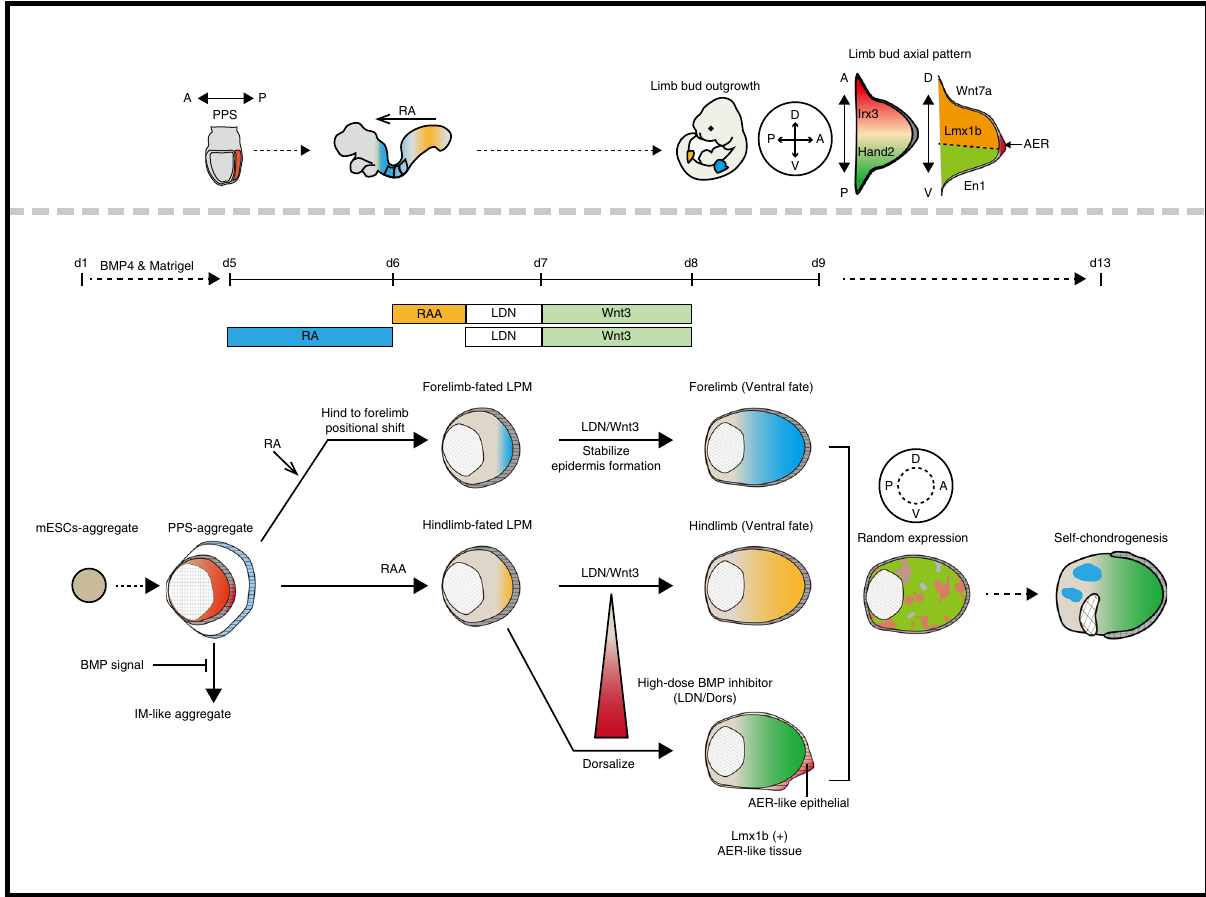
Fig. 6 Schematic model of the differentiation of ES – LB. The developmental process of mouse embryo from E7.5 to 10.5 (above gray dotted line), which correlated with each time-course of the ES – LB differentiation. mESC aggregates differentiate into PPS aggregate by applying BMP4 and matirgel on days 1 – 5. PPS-aggregates demonstrate mesodermal lineage shift from LPM to IM by inhibiting BMP signal. PPS-aggregates differentiate into LPM, and regional identity of fore or hindlimb bud-derived LPM could be controlled by adjusting RA signal activity. On days 7 – 8, Wnt3 effectively stabilizes thickened ectoderm. On day 9, ES – LB shows limb bud-like morphology, however, the state of gene expression indicates ventral-biased and no reproducible pattern. On the other hand, the addition of high-dose LDN (1 μ M) or DM (10 μ M) on days 6.5 – 7 elicit dorsalization (Lmx1b + ) and induction of AER-like tissue in the ES – LB ectoderm. On day 13, ES – LB indicates self-differentiation of immature cartilage. ES – LB, mESCs-derived limb bud; PPS, posterior primitive streak; A-P, anterior – posterior; D-V, dorsal-ventral; RA, retinoic acid; RAA, retinoic acid antagonist; LDN, LDN193189 (BMP inhibitor); DM, dorsomophin